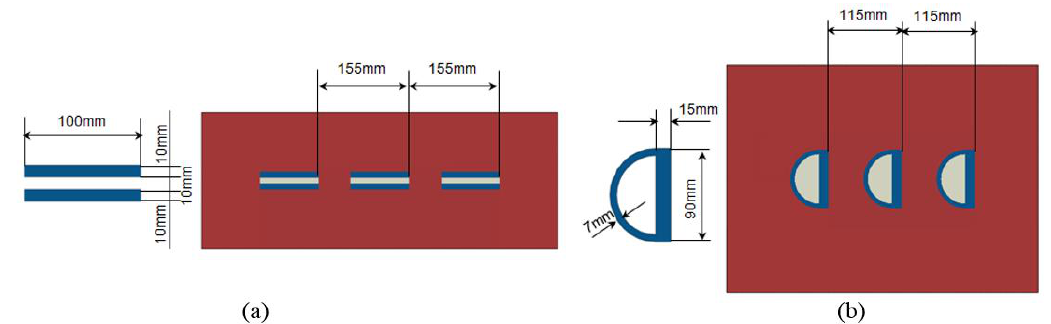
Figure 6. Geometry of 3-phase parallel arrays of bus-bars: ( a ) Plate-type, ( b ) Tunnel-type.